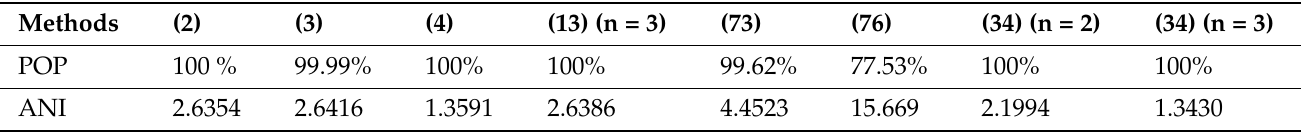
Table 2. Numerical results of different methods for z 3 − 1 = 0.